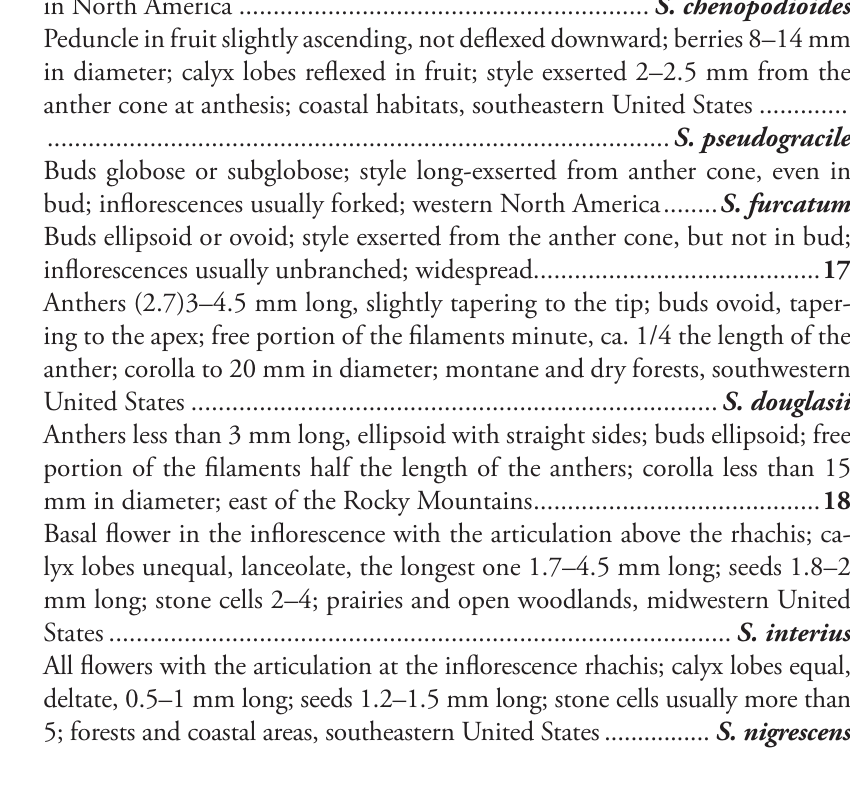
Peduncle in fruit at right angles or more usually strongly deflexed down- wards; berries 4–9 mm in diameter; calyx lobes appressed to surface of berry in fruit; styles exserted to 1.5 mm from the anther cone at anthesis; adventive in North America ............................................................ S.